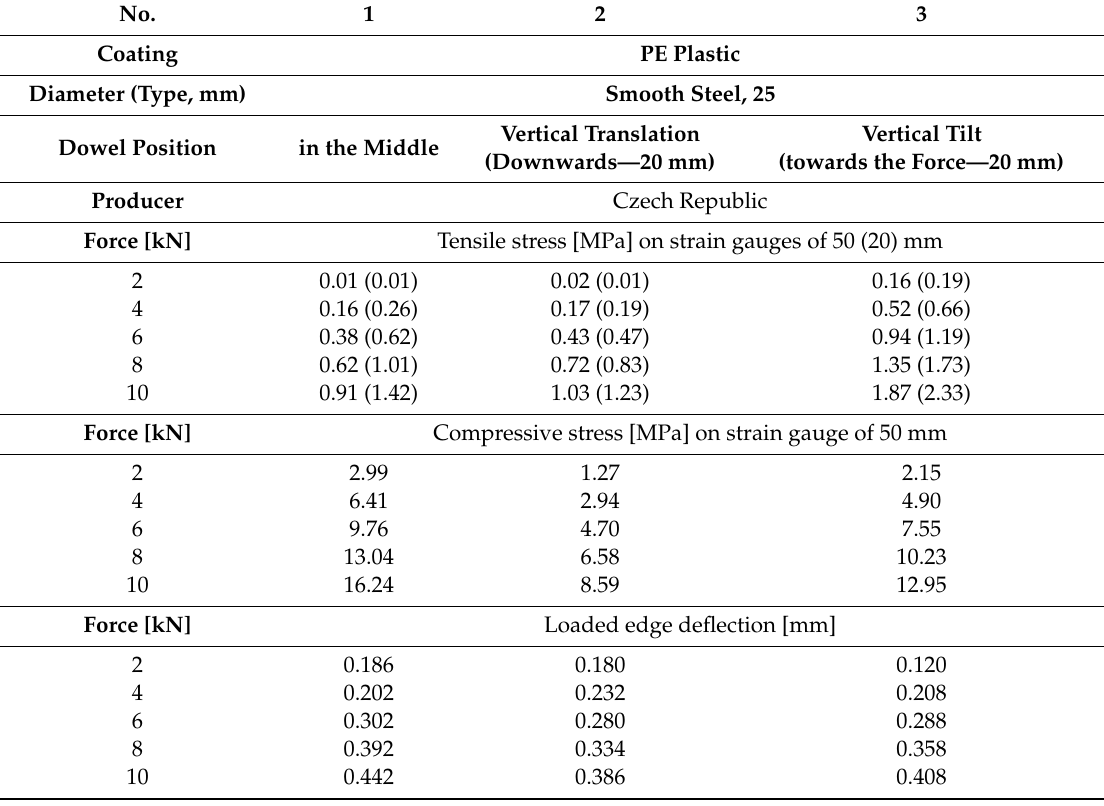
Table 2. Deformation measurement results on beams 150 × 150 × 350